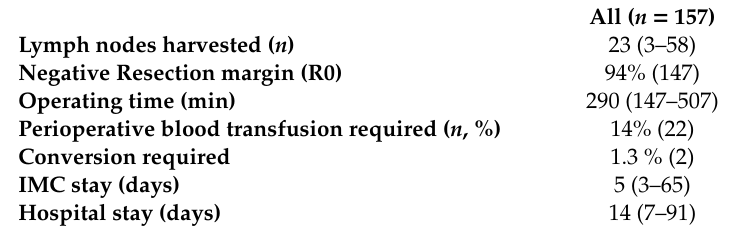
Table 2. Procedure and hospital stay